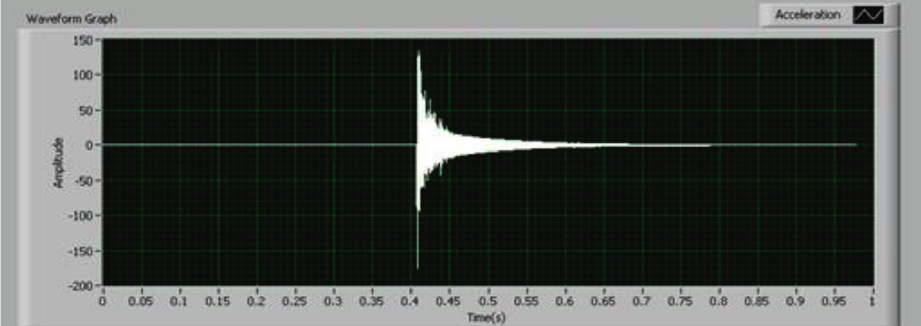
Figure 5: Time (sec) domain excitation response of Mg alloy under natural frequency.